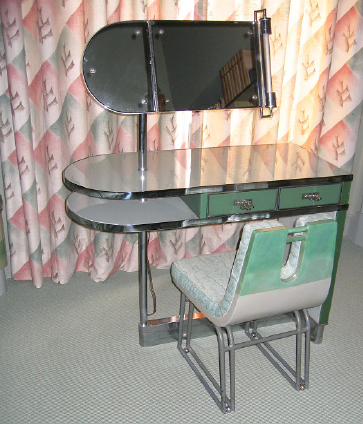
Figure 11. Molle apartment, Mrs. Molle’s dressing room with fabrics decorated by Fides Testi, about 1932. © Archivi delle arti applicate italiane del XX secolo, Rome. Used by permission.